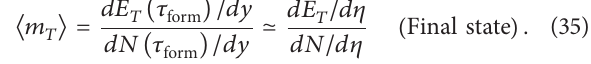
, plotted in Figure NN